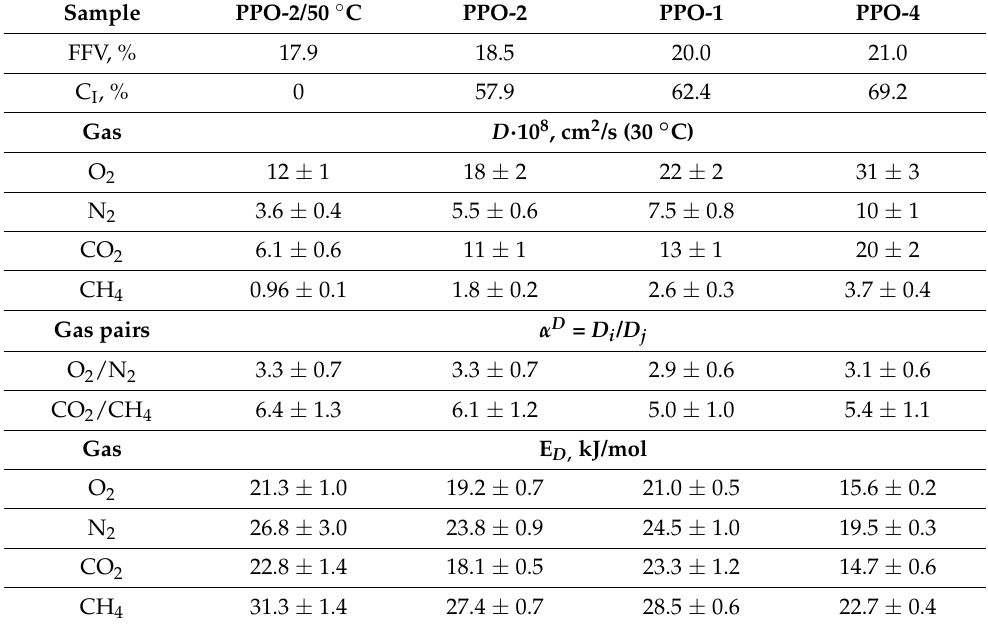
Table 5. Gas diffusion coefficients, diffusion selectivities, and diffusion activation energies of the studied PPO films.